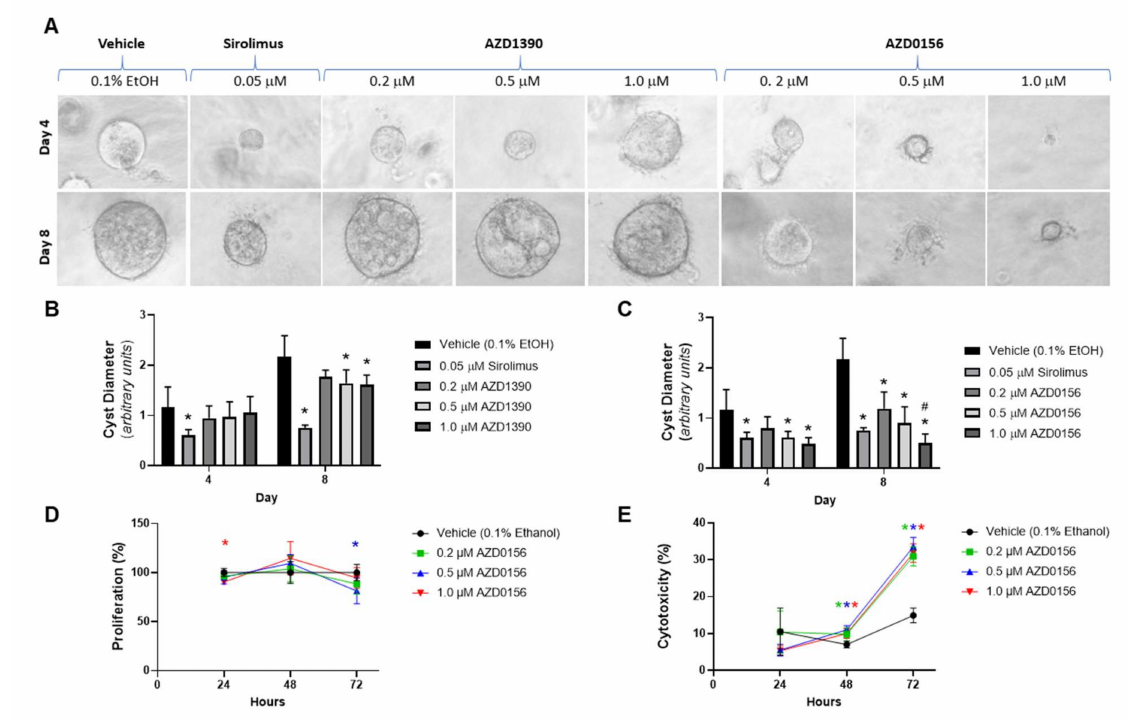
Figure 2. Effect of ataxia-telangiectasia mutated (ATM) inhibitors (AZD1390 and AZD0156) on MDCK cyst growth, cell proliferation and cytotoxicity in vitro. MDCK cysts were treated with either vehicle (0.1% ethanol (EtOH), sirolimus (0.05 µ M), AZD1390 (0.2, 0.5, and 1 µ M) or AZD0156 (0.2, 0.5, and 1 µ M) for up to 8 days. ( A ) Representative images of MDCK cysts treated with either vehicle, sirolimus, AZD1390 or AZD0156 on Days 4 (upper panel) and 8 (lower panel) (Images were obtained using 10 × objective). ( B ) and ( C ) Mean cyst diameter in response to AZD1390 ( B ) and AZD0156 ( C ) on Days 4 and 8. * p < 0.05 compared to vehicle, and # p < 0.05 compared to 0.2 µ M of respective treatment. ( D ) Mean cell proliferation (measured by the BrdU assay) and ( E ) Mean percentage cytotoxicity (measured using the LDH assay) following treatment with either AZD0156 or vehicle. * p < 0.05 compared to vehicle (color of asterix corresponds to the respective line color). All p -values in figure were determined by one-way ANOVA, followed by post hoc analysis with the Tukey–Kramer HSD test, and data presented as means ± SD ( n = 6 per